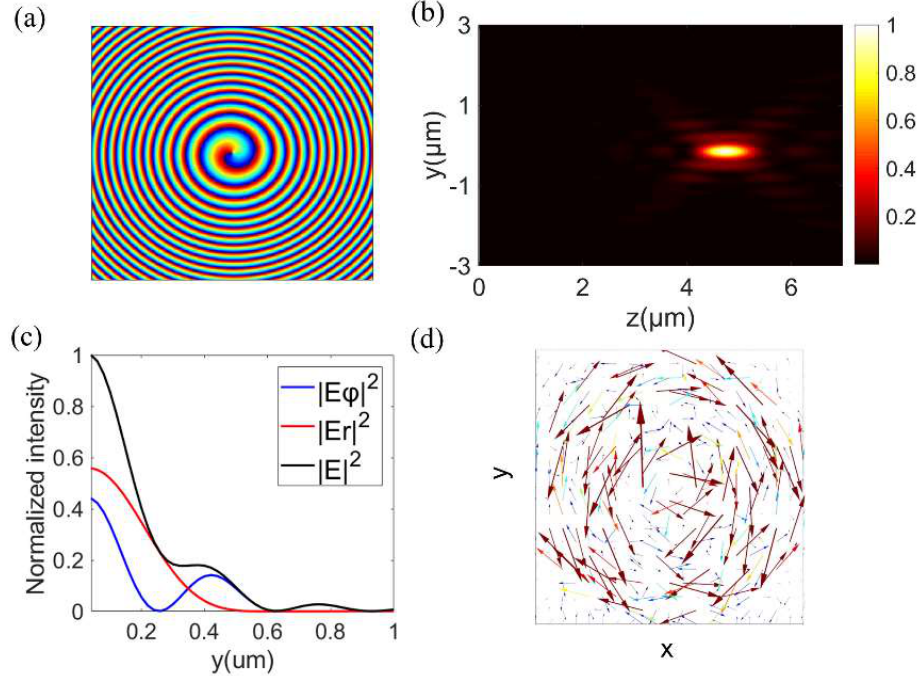
Figure 4. ( a ) The theoretical phase distributions of the designed metalens. ( b ) The intensity distribution in the propagating y–z plane of the focal field. ( c ) A radial normalized intensity distribution in the focal plane. ( d ) The polarization distributions of the x–y plane near the metalens (z = 100 nm).